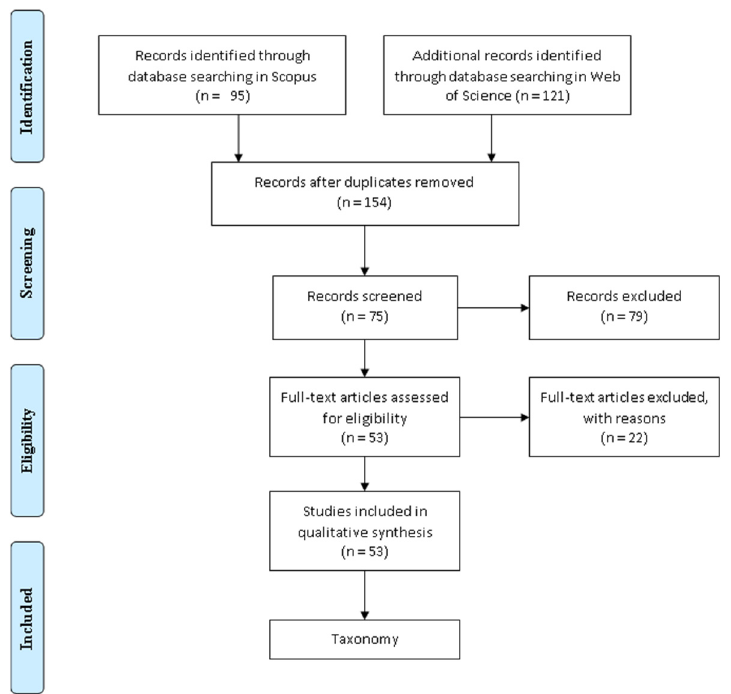
Figure 3. Systematic review methodology.